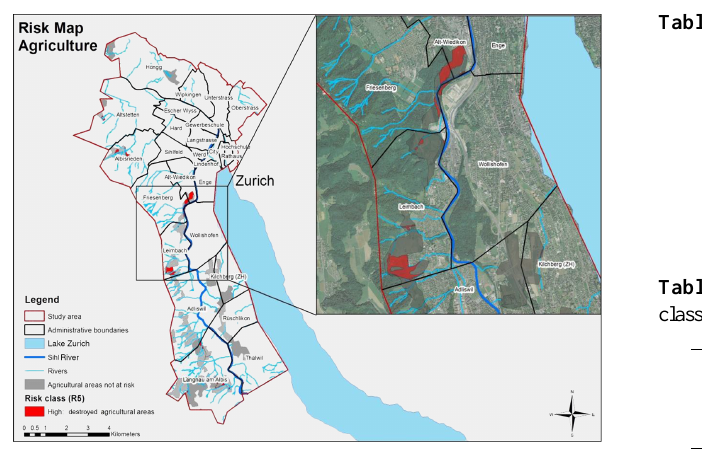
Figure 9. Relative risk map for agriculture, showing flooded and destroyed agricultural areas, with an inset of the most affected area.